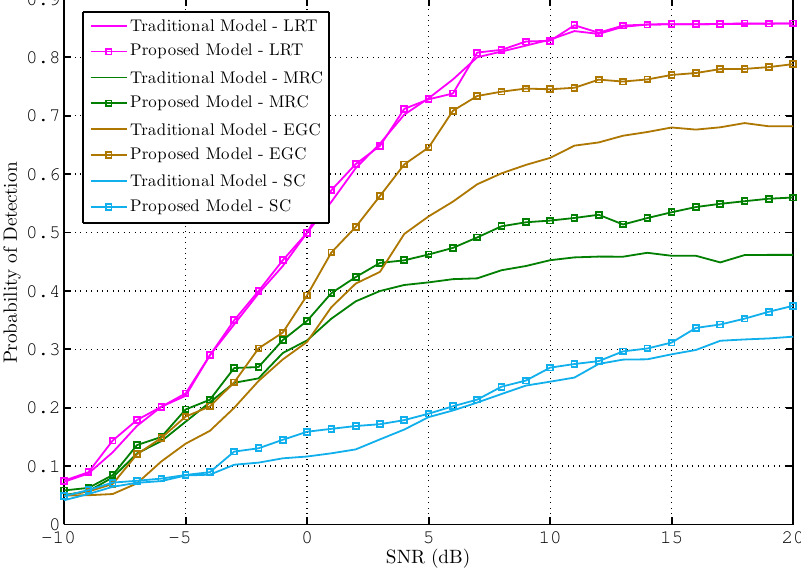
Figure 6. Probability of detection as a function of average channel SNR; sensors have different detection performance, total number of sensors K =